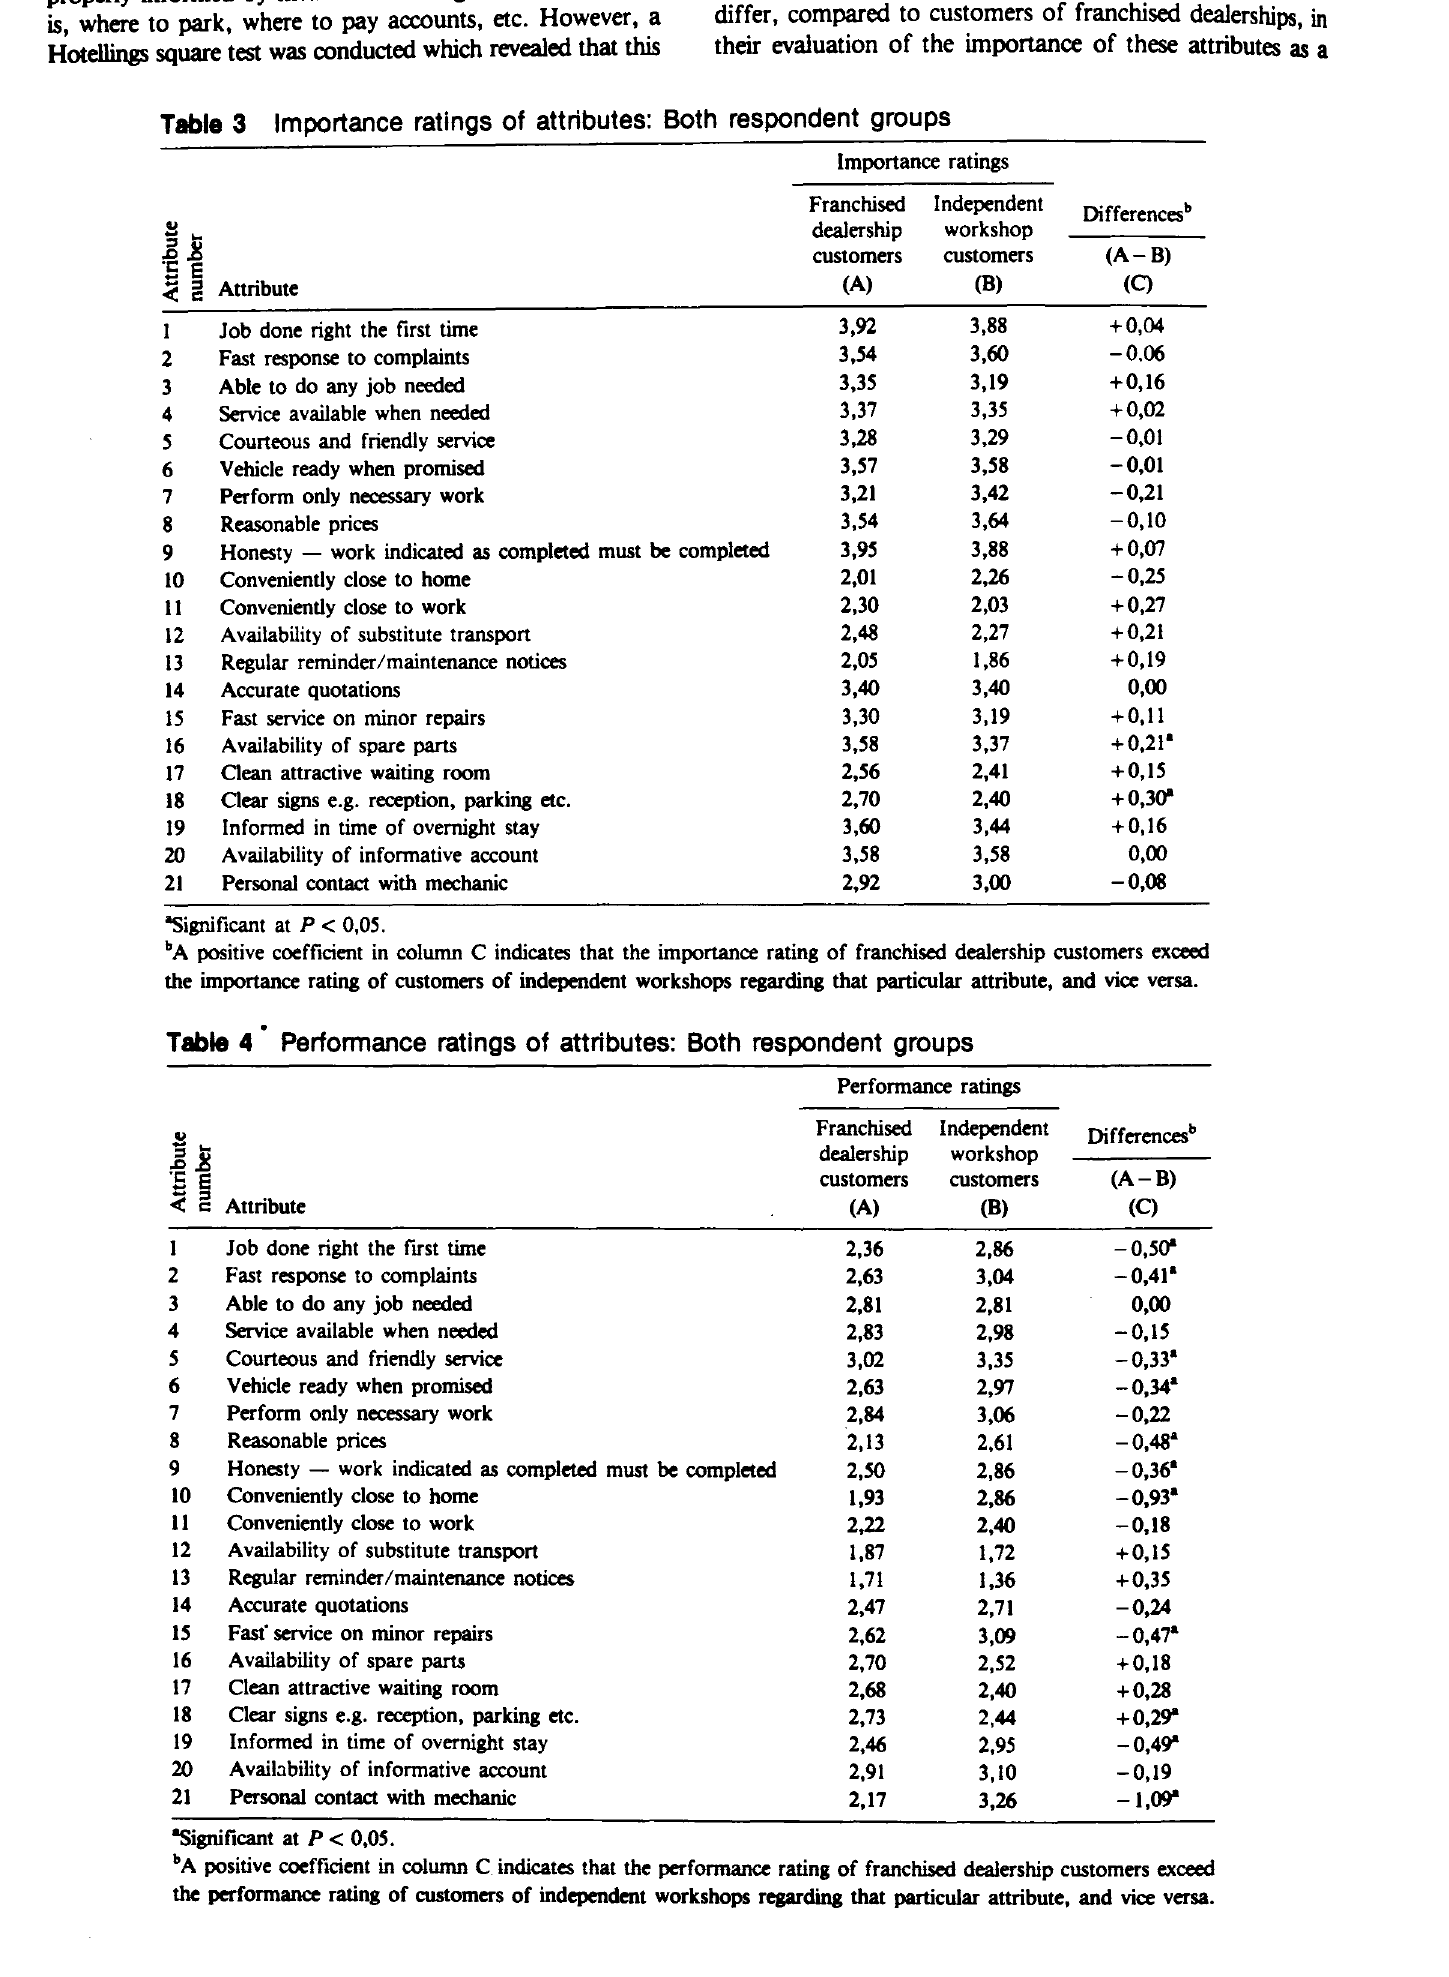
Importance ratings of attributes: Both respondent groups